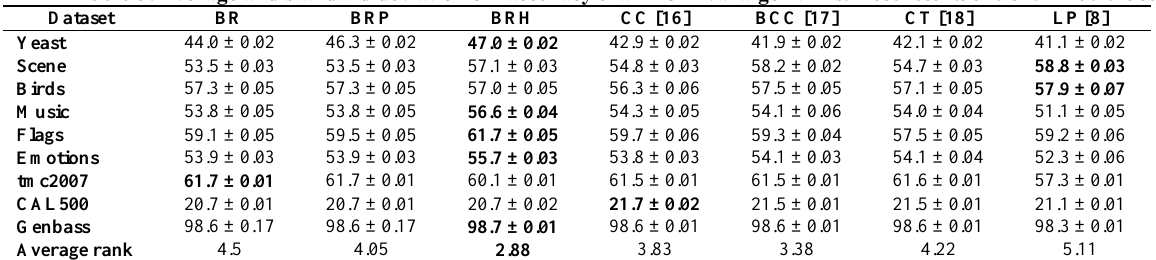
Table 3. Average and standard deviation of “accuracy exam” of rival algorithms. Best results are shown boldface. Dataset BR BRP